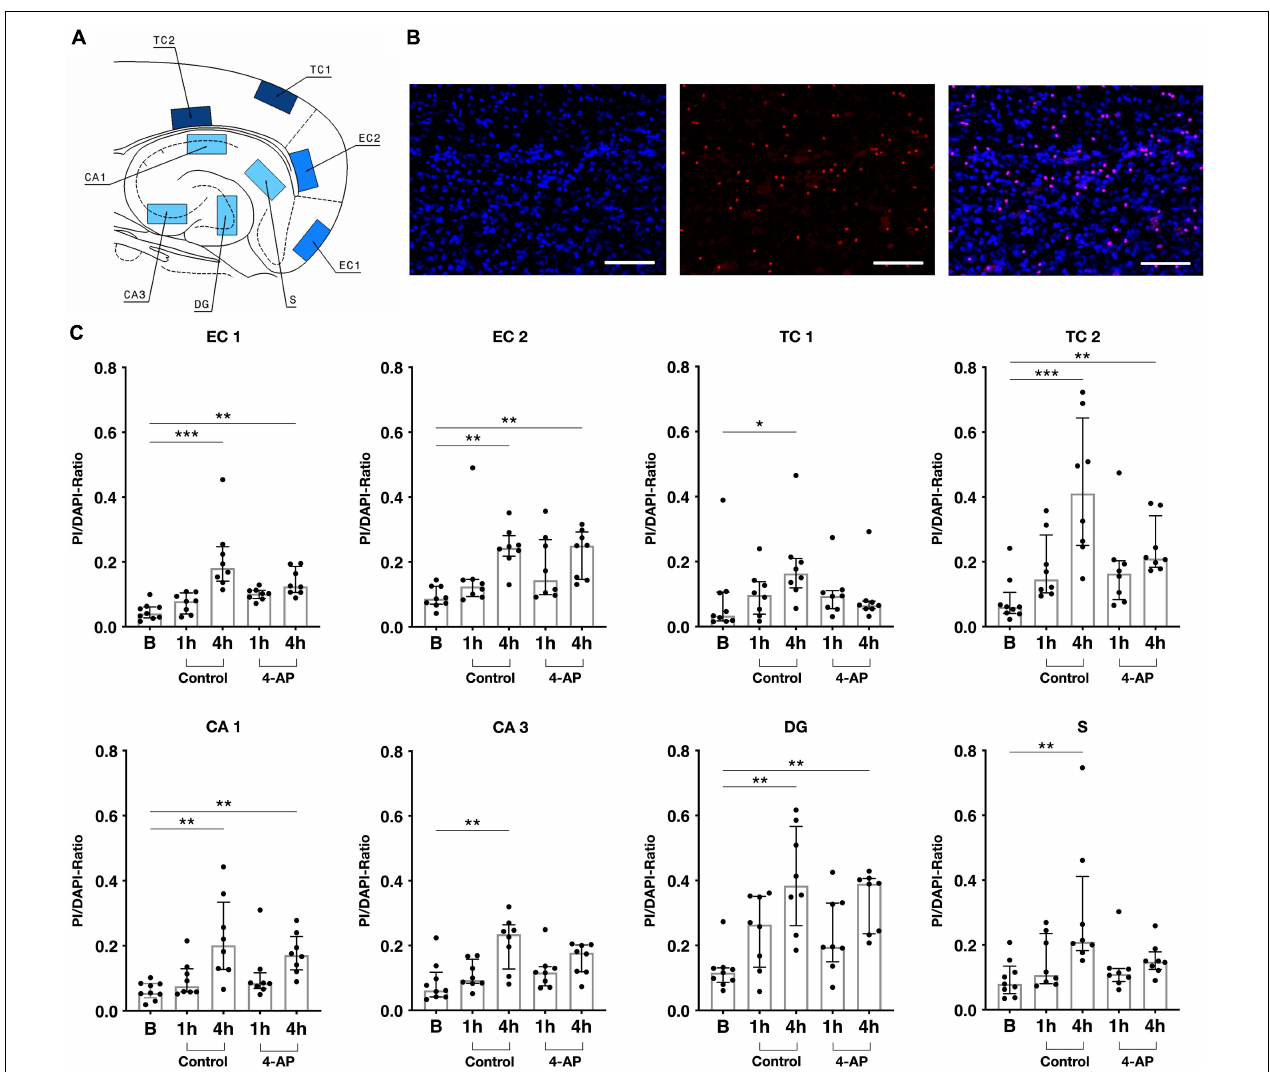
FIGURE 4 | Cell death assay for rat slices. (A) Schematic depiction of a rat slice with eight visual fields (500 × 300 µ m) in which cells were counted: two layers of each entorhinal (EC1 and EC2) and temporal cortex (TC1 and TC2) as well as subiculum (S), CA1, C3 and dentate gyrus (DG). (B) Exemplary images acquired by an inverted confocal microscope (20 × magnification, merged Z plane image stack), left: DAPI staining (2 µ g/ml), in center: PI staining (1 µ g/ml), right: merged. Scale bar 100 µ m. (C) Slice viability measured as ratio of PI (dead) and DAPI (total) positive cells in n = 41 slices (9 × basal, 8 × control 1 h, 8 × control 4 h, 8 × 4-AP 1 h, 8 × 4-AP 4 h). Scatter plots represent PI/DAPI-Ratio of individually stained slices, superimposed boxes show median ± interquartile range (* p < 0.05, ** p < 0.01, *** p <